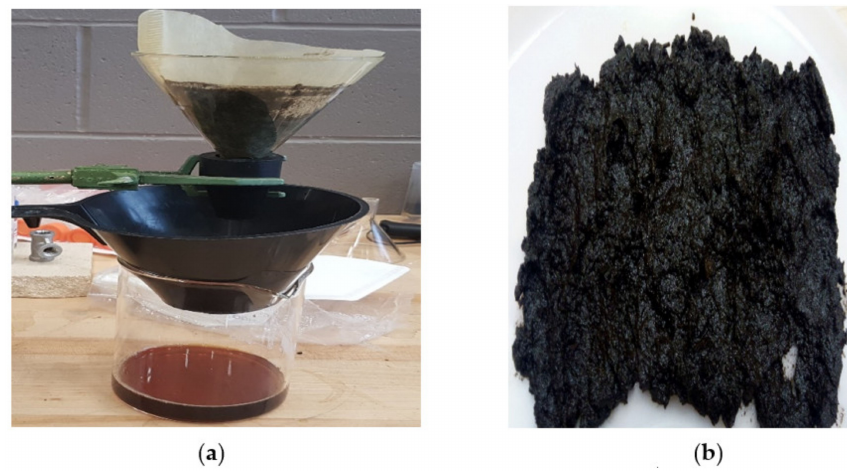
Figure 2. Gravity filtration of HTC products. ( a ) process water and ( b ) wet